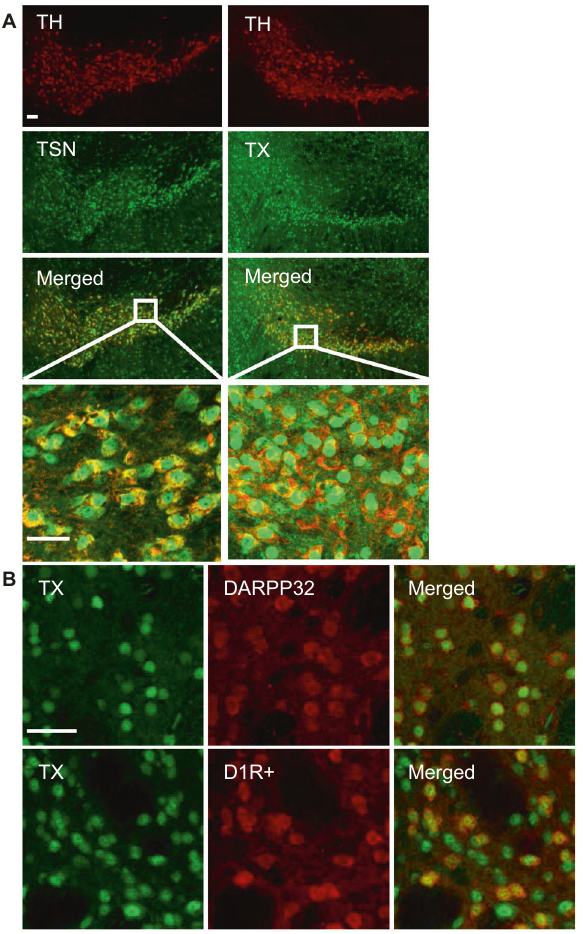
Fig. 1 Localization of TN and TX to DA neurons and striatal neurons. A Double immunostaining of midbrain sections for TH (red) and TN or TX (green) shows TN or TX expression located in the VTA or substantia nigra. B Immunostaining in striatal medium spiny neurons shows prominent nuclear TX staining (green) in DARPP-32 positive neurons (red) (top row). TX staining of sections from mice expressing tdTomato in D1R + neurons demonstrates that TX is expressed in both D1R-positive neurons as well as in D1R-negative neurons (bottom row). Scale bar, 30 μ